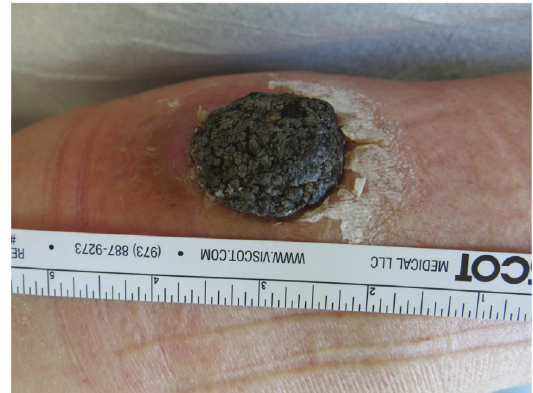
Figure 5. Irritated seborrheic keratosis resembling verrucous squamous cell carcinoma. This figure is an original image